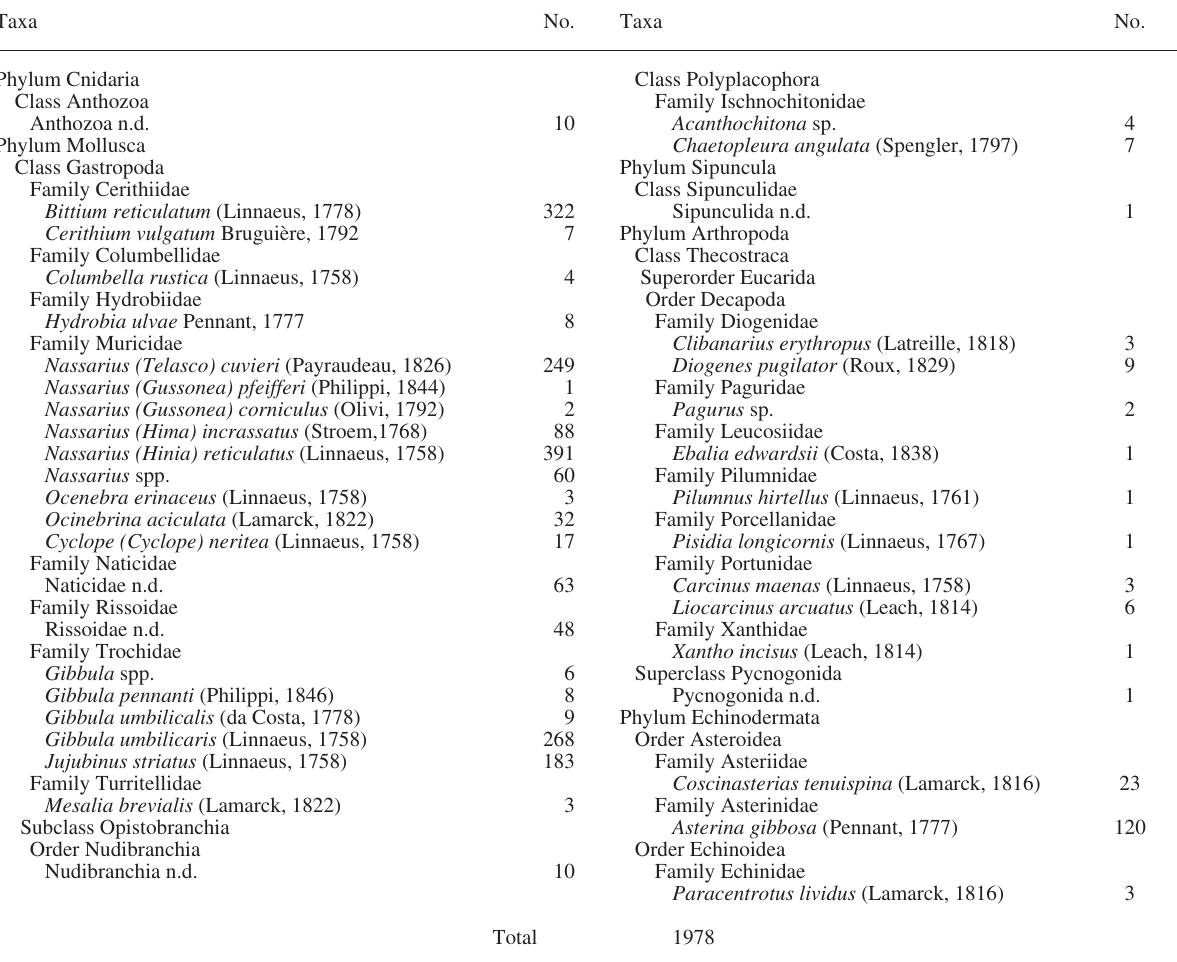
the by-catch species caught by the “wallet-lines” are compiled in table 2. overall, 1978